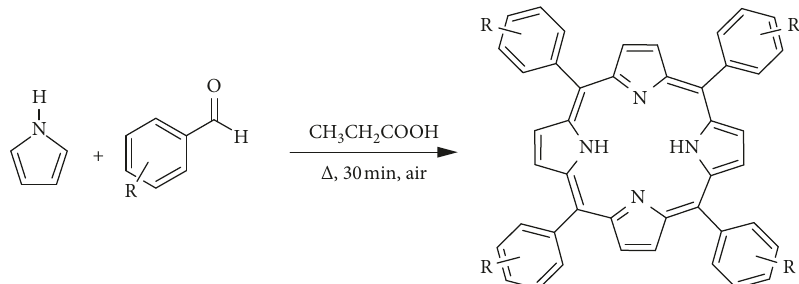
Figure 13: Synthesis of mesosubstituted tetraphenylporphyrin in open air [158].